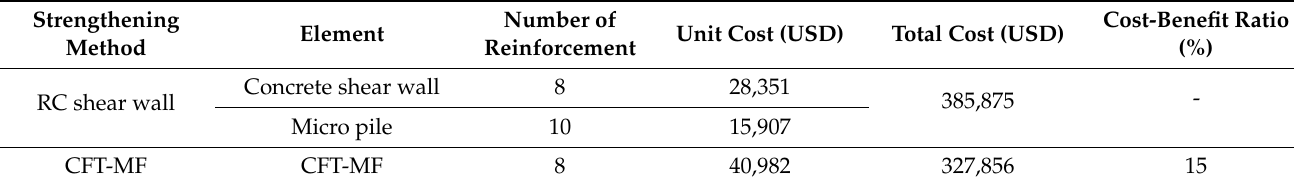
Table 2. Cost evaluation between the CFT-MF and the conventional adding infill shear wall strengthening methods. Strengthening